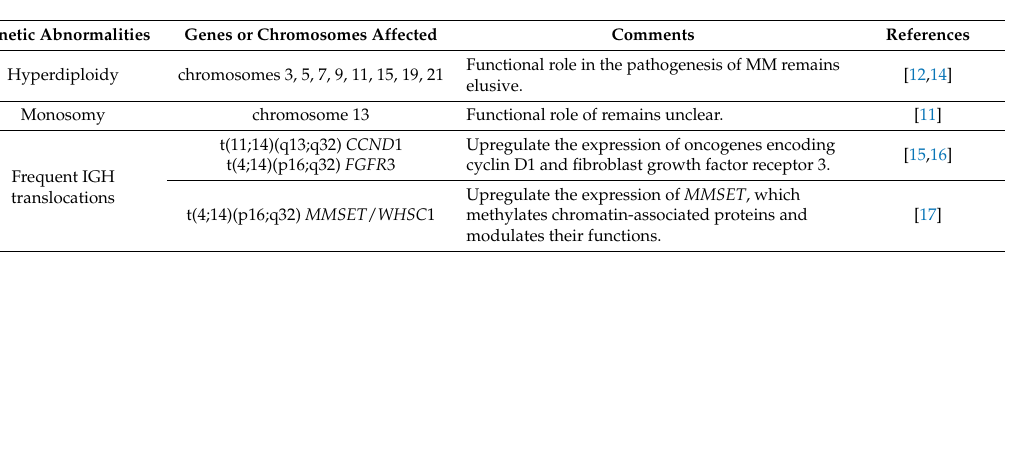
Table 1. Genetic abnormalities in multiple myeloma